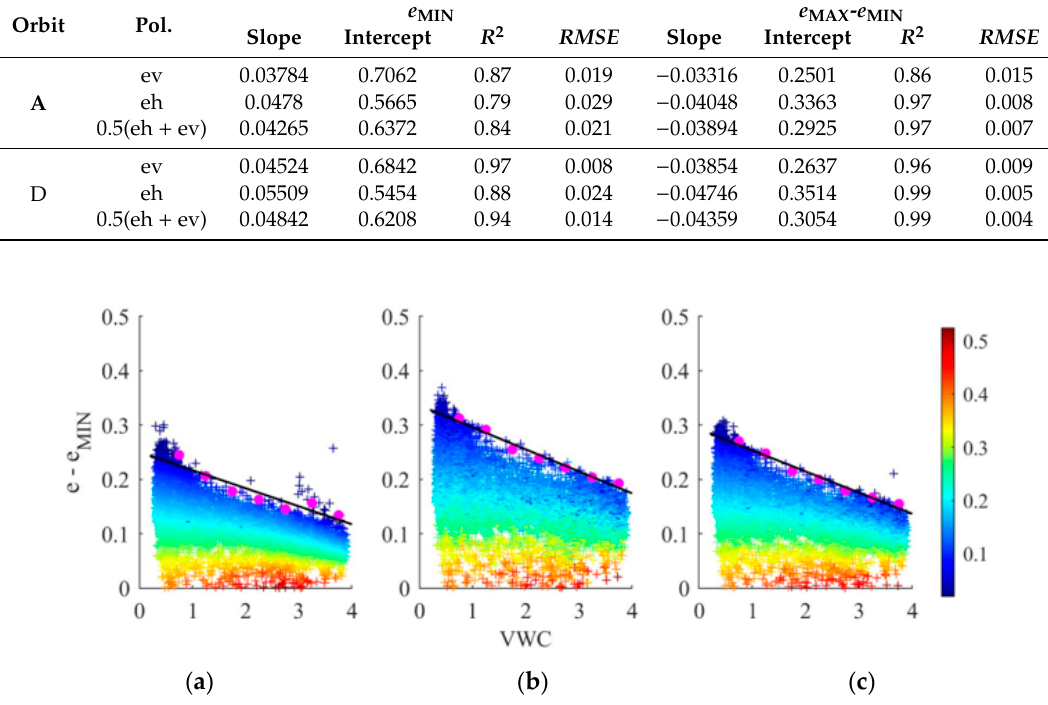
Figure 5. Difference between maximum and minimum of surface emissivity for vertical ( a ), horizontal ( b ) and combined vertical and horizontal ( c ) polarization at different VWC levels based on the ascending SMAP dataset. The color of ‘+’ indicates the change of SSM. The pink circles represent e MAX − e MIN calculated by each VWC interval. The black solid line is the fitted linear relationship between e MAX − e MIN and VWC.